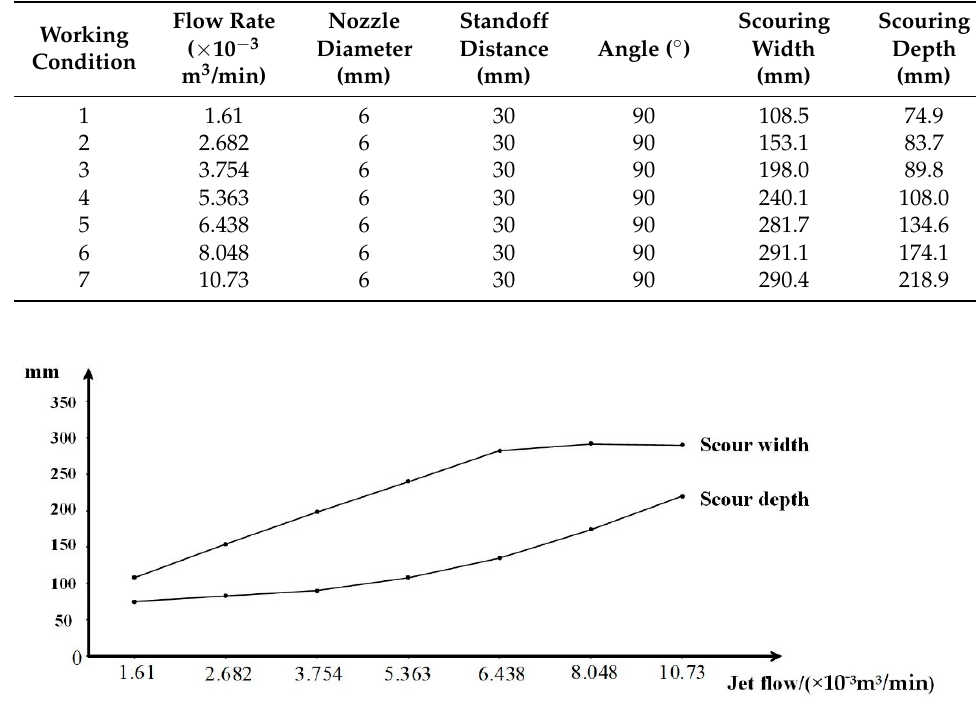
Figure 21. Scour depth and width at different jet flows.